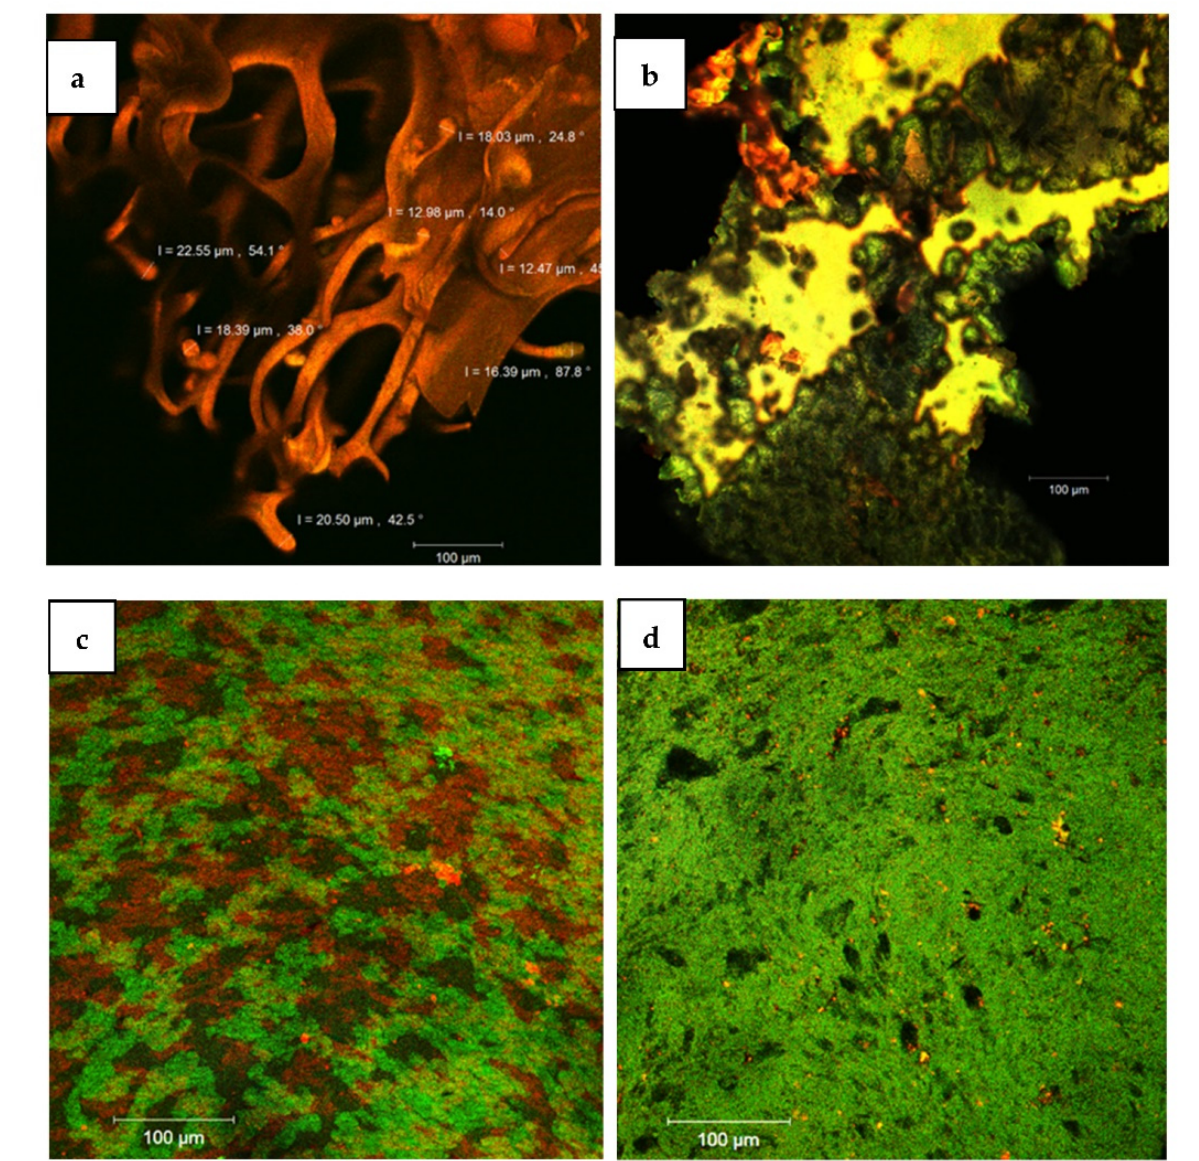
Figure 4. Confocal laser scanning images of the microencapsulated powders: V1 (( a )—native, ( c )—stained) and V2 (( b )—native, ( d )—stained) .